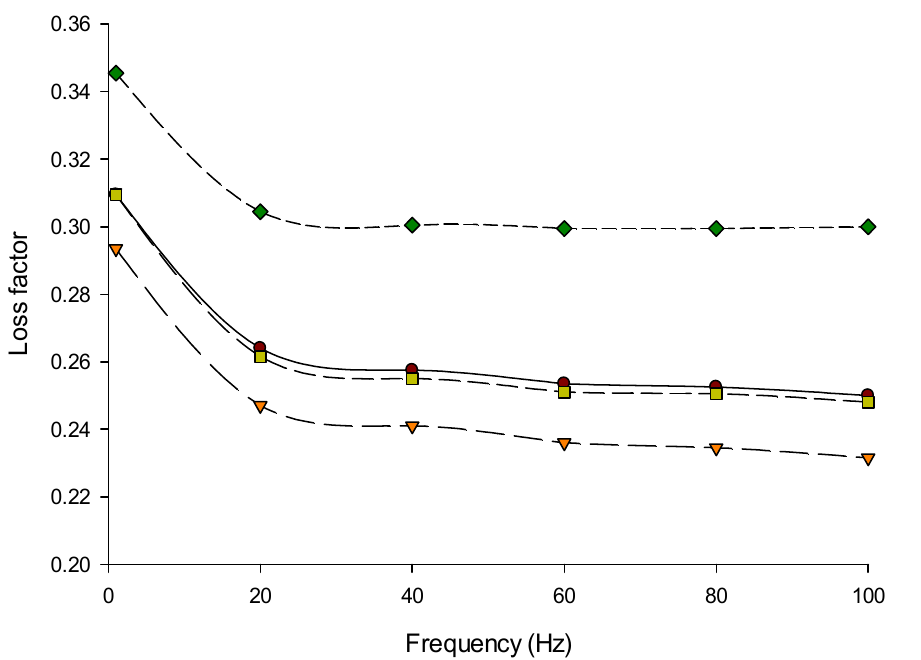
Figure 4. Loss factor (tan δ = G ′′ /G ′ ) of Feta-type cheese made from micellar casein concentrate (MCC). Treatment: Control ( ● ) = Feta-type cheese made from whole milk; MCC-3 ( ▼ ) = Feta-type cheese made from MCC solution with 3% protein; MCC-6 ( ■ ) = Feta-type cheese made from MCC solution with 6% protein; MCC-9 ( ♦ ) = Feta-type cheese made from MCC solution with 9% protein measured at a range of 0.1 to 100 Hz frequency at 20 °C using dynamic rheological analysis (DSR).